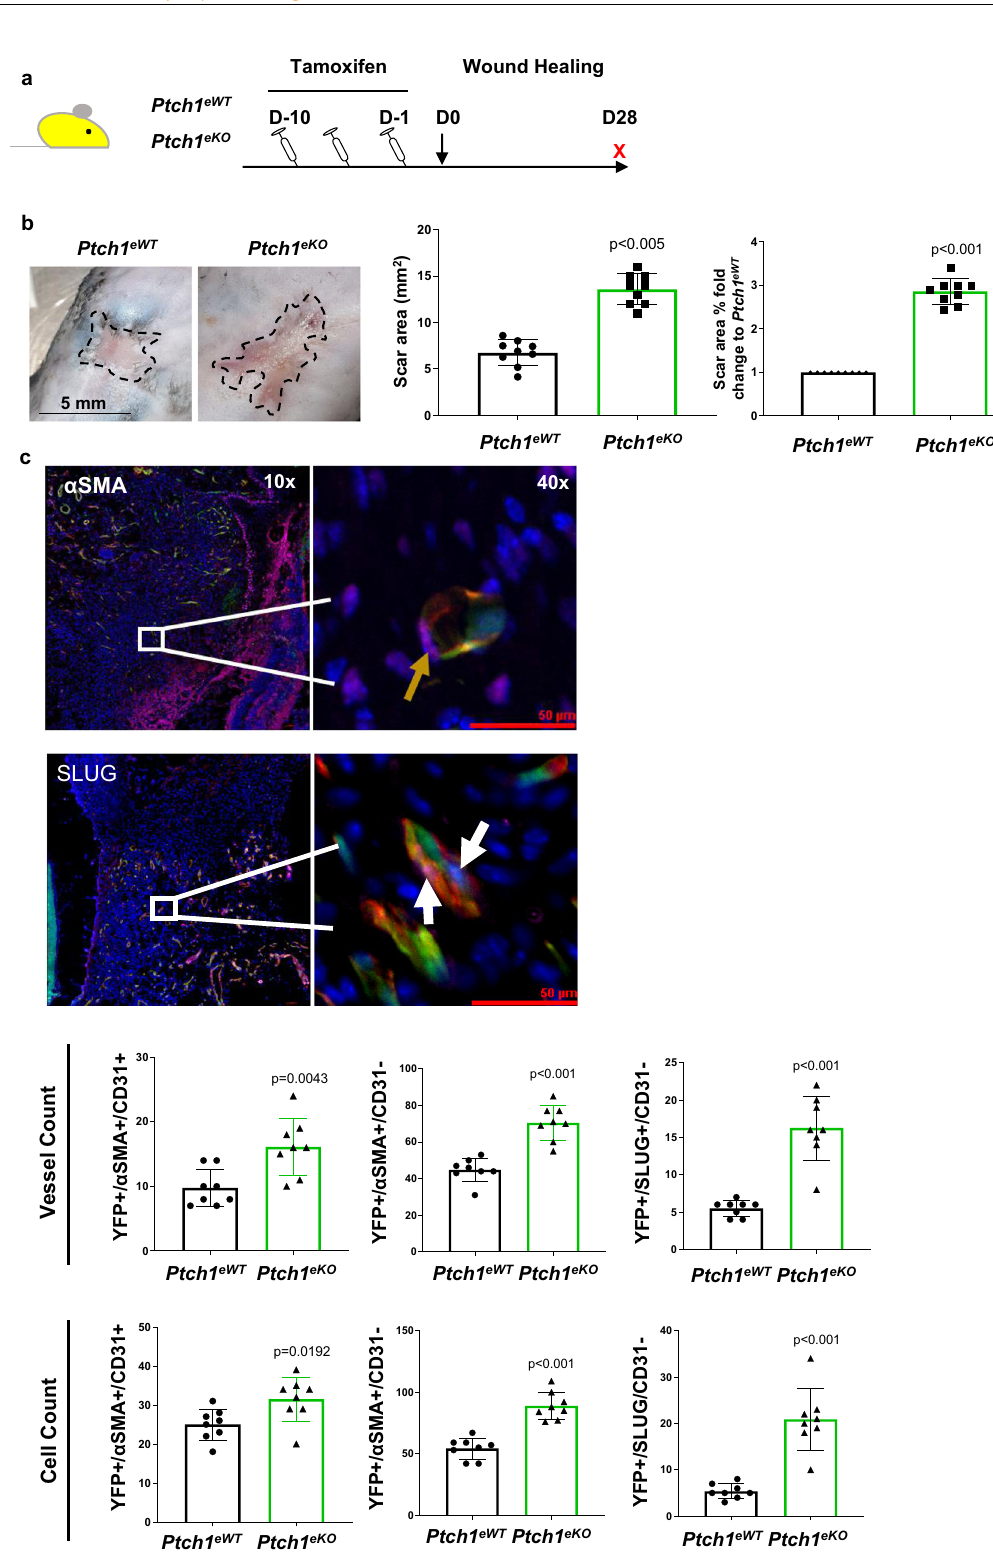
the dorsal fl anks of the Ptch1 eWT and Ptch1 eKO mice following 10 days of IP tamoxifen injections. Wounds were then harvested at day 7 (D7) and assessed for EndMT using SLUG and α -SMA. As expected, a signi fi cant increase in YFP + vessel and cell counts expressing both SLUG and α -SMA were observed in Ptch1 eKO wounds compared to controls. Importantly, this also coincided with a signi fi cant increase in YFP + α SMA + ( p = 0.0043